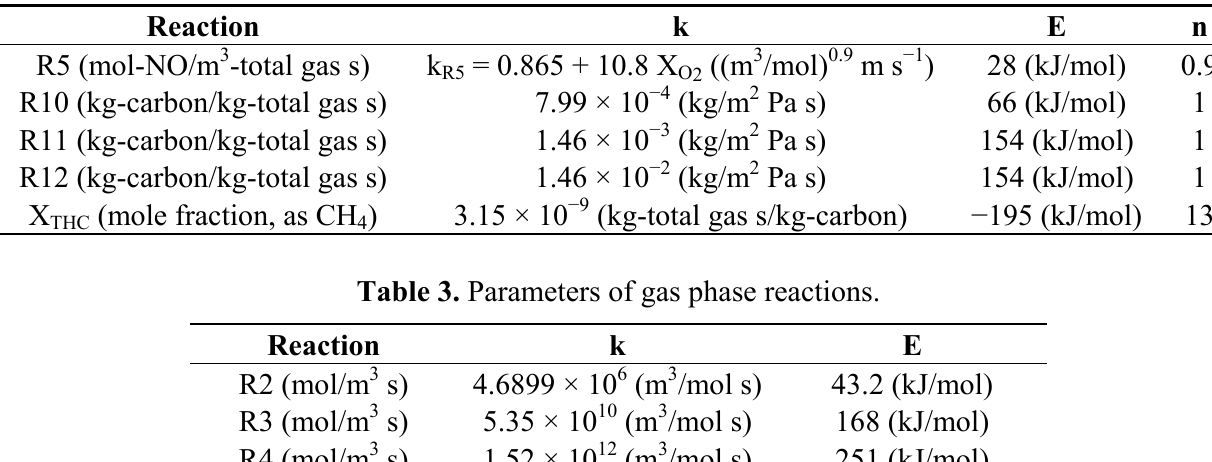
Table 2. Parameters of solid phase reactions.